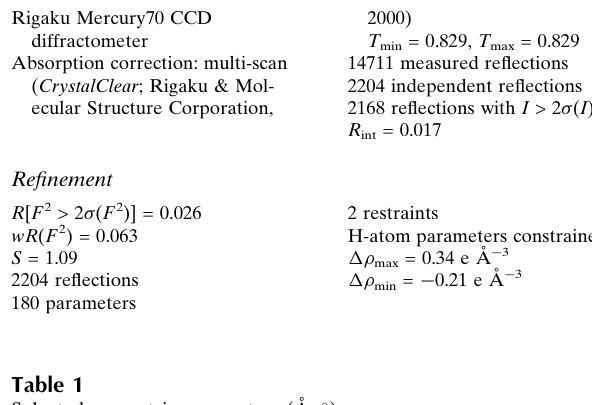
Selected geometric parameters (A˚ , (cid:4) ).